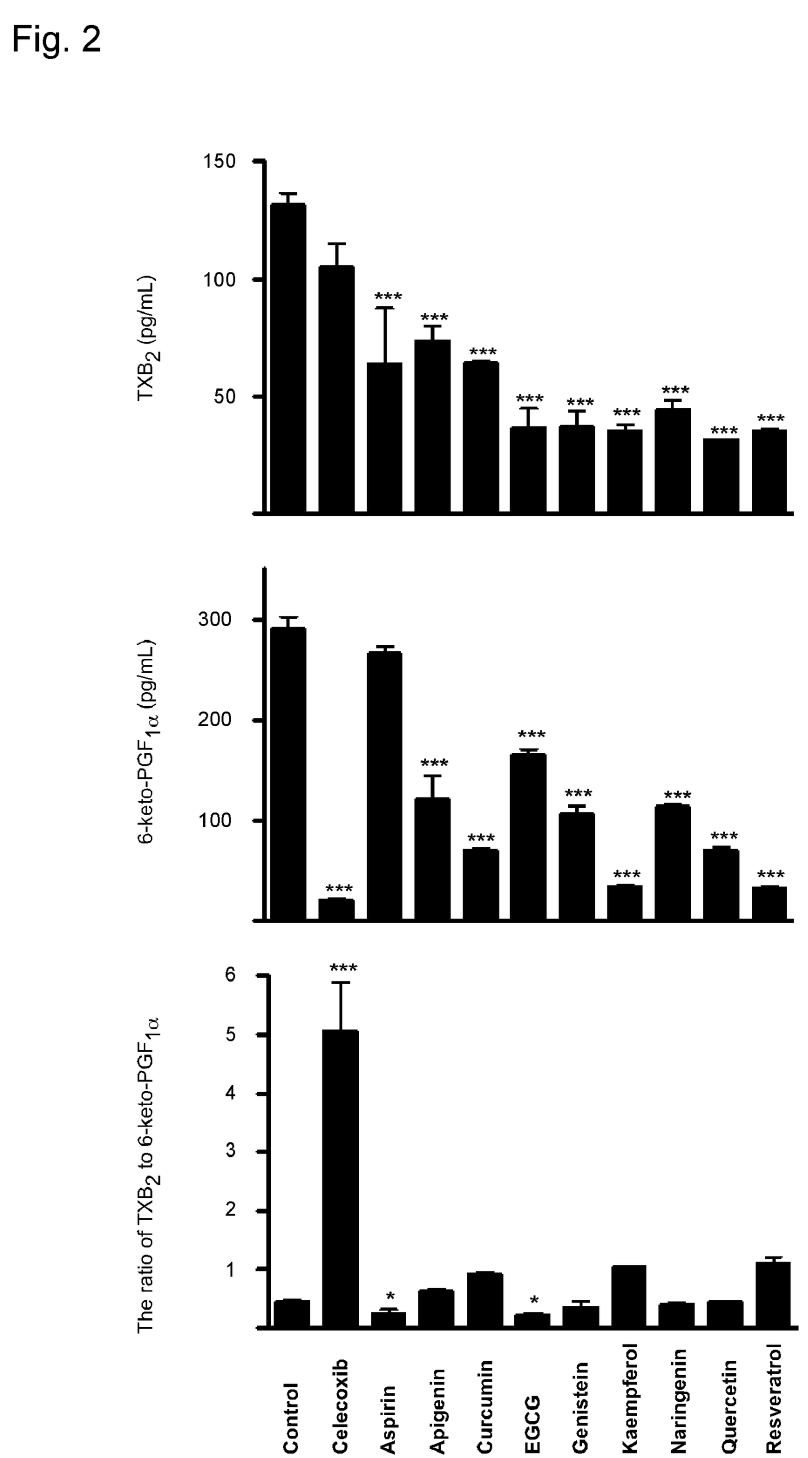
Figure 2. Effects of dietary phytochemicals on (A) TXB and (B) 6-keto-PGF α under physiological conditions. HUVECs 2 1 were seeded in a six-well-plate (6×10 5 cells per well). At 70-80% confluence, 1 mL fresh medium containing DMSO or 3 µM of each individual compound was added and cells were further incubated for 8 h. Supernatant fractions were collected for prostaglandin measurement. (C) The ratio of TXB /6-keto-PGF α. Data are presented as means ± S.E.M (n = 4) and the asterisk(s) indicate a 2 1 significant (*, p < 0.05; ***, p < 0.001) difference versus the vehicle control group. doi: 10.1371/journal.pone.0076452.g002 PLOS ONE |